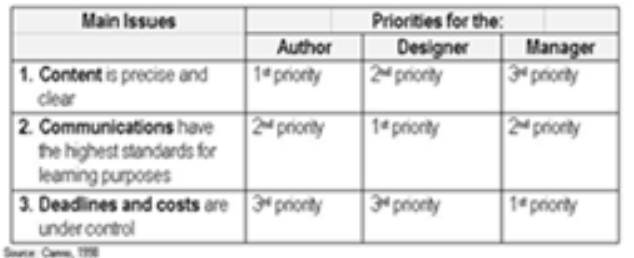
Relationships between author, designer and manager issues and instructional design/media production